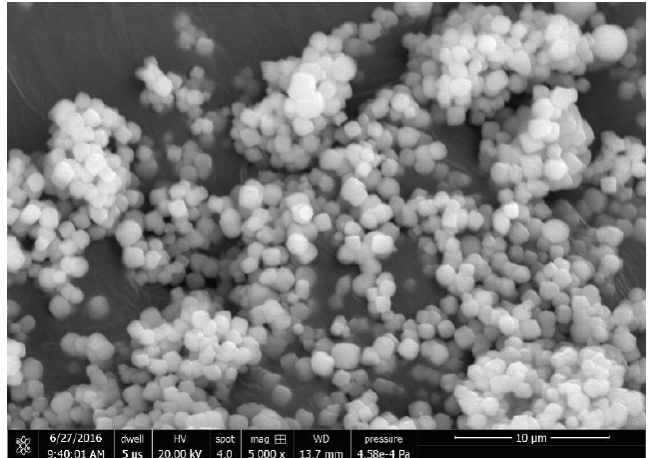
Figure 10. The SEM results of 0.5 h of seed grinding.